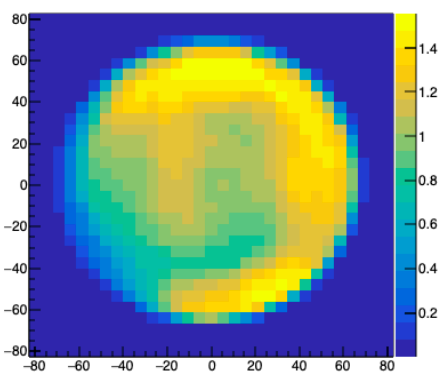
Figure 10. Example of a measurement of non-uniformity of PMT gain to be used for new configuration.